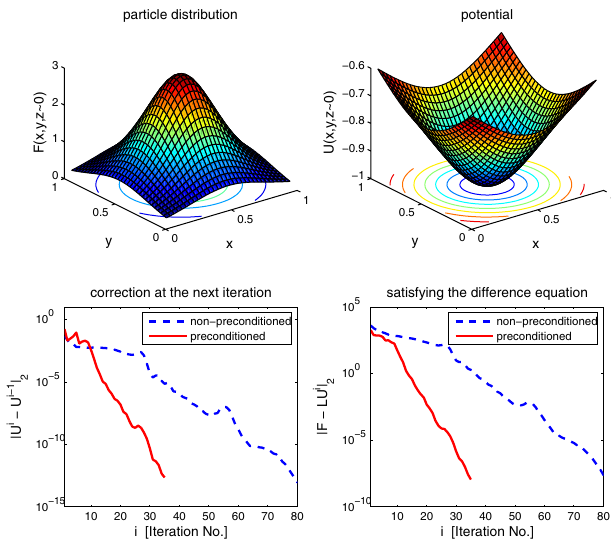
FIG. 10. (Color) Plummer spherical particle distribution (top left) and corresponding potential (top right) at the waist ( z (cid:12) 0 ) obtained using the PCG solver. The lower panels show two convergence criteria—correction at the next iteration (bottom left) and the norm of the residual of the difference equation (bottom right)—with (solid line) and without (dashed line) the preconditioner. A poor initial approximation was chosen: U (cid:2) x ; t (cid:4) 0 (cid:3) (cid:4) 0